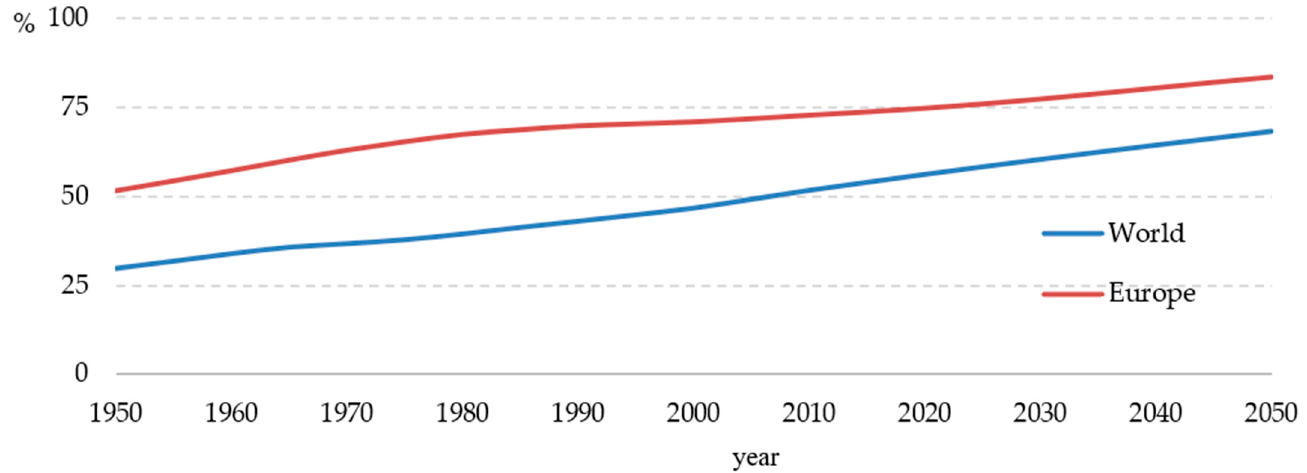
Figure 1. Predicted percentage of total population living in cities (own research on the basis of [1]).